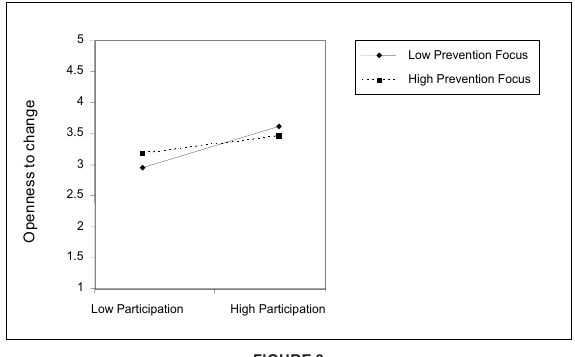
FIGURE 8 in sample